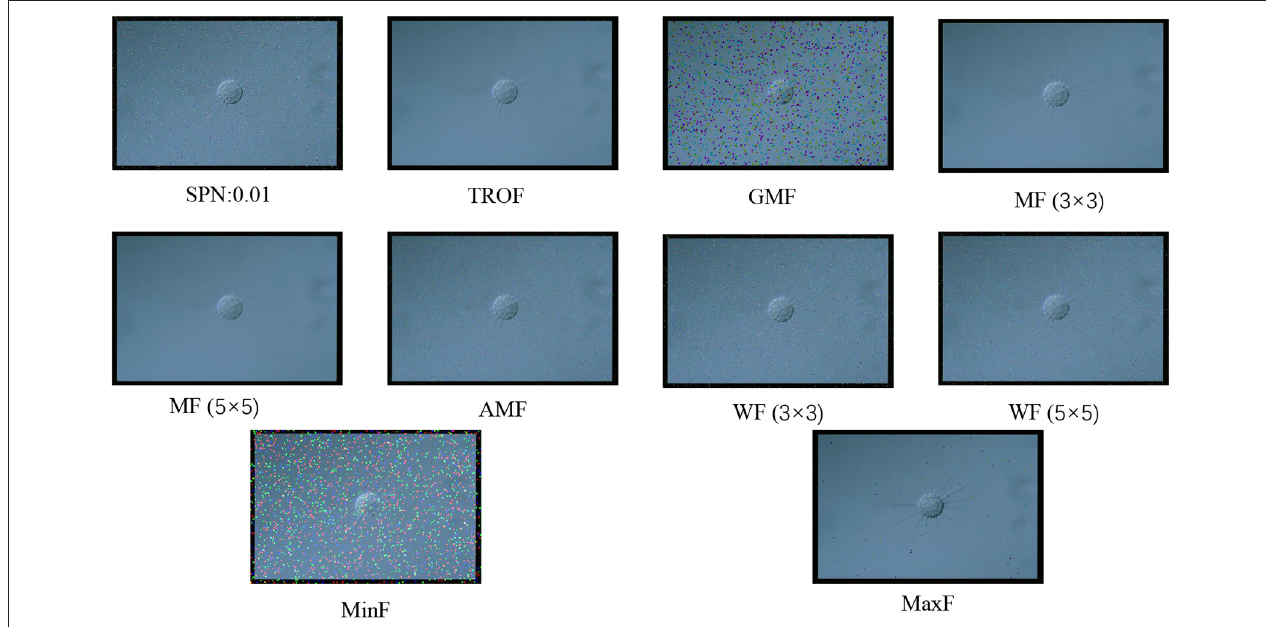
FIGURE 2 | Examples of using different filters to filter salt and pepper